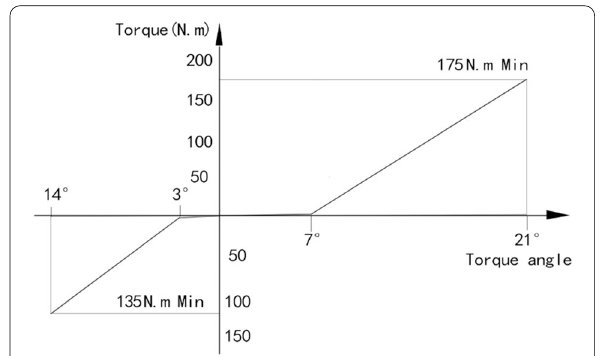
Figure 7 Graph showing torsion performance of traditional clutch